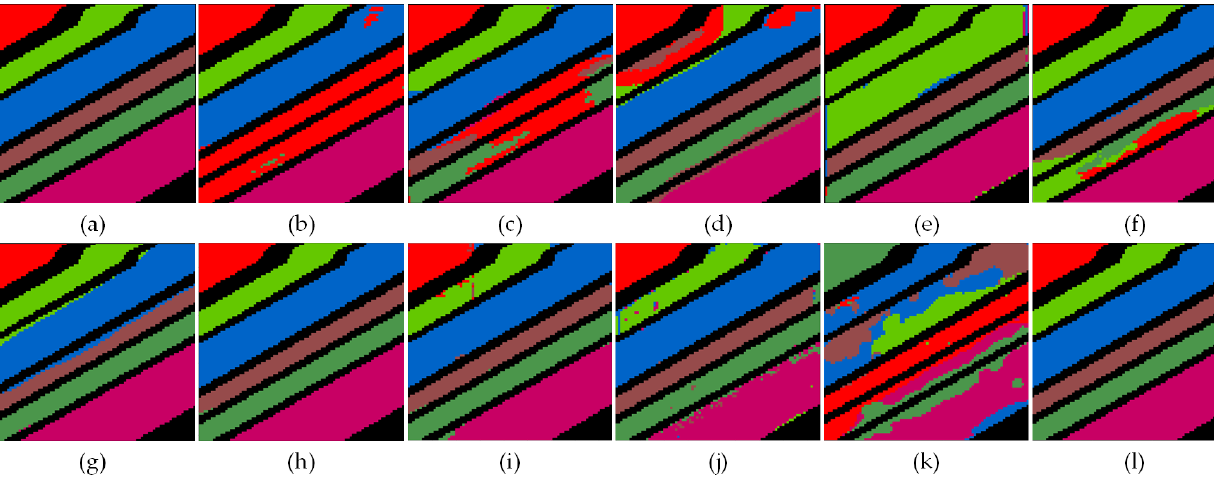
Figure 15. Classification results of the models in comparison with the SA dataset. ( a ) Ground-truth labels, ( b – l ) classification results of SVM, MLR, RF, 1D-CNN, 2D-CNN, 3D-CNN, Hybrid, JSSAN, RSSAN, TSCNN and SSMFF Table 8. Classification results of different methods for the SA dataset.